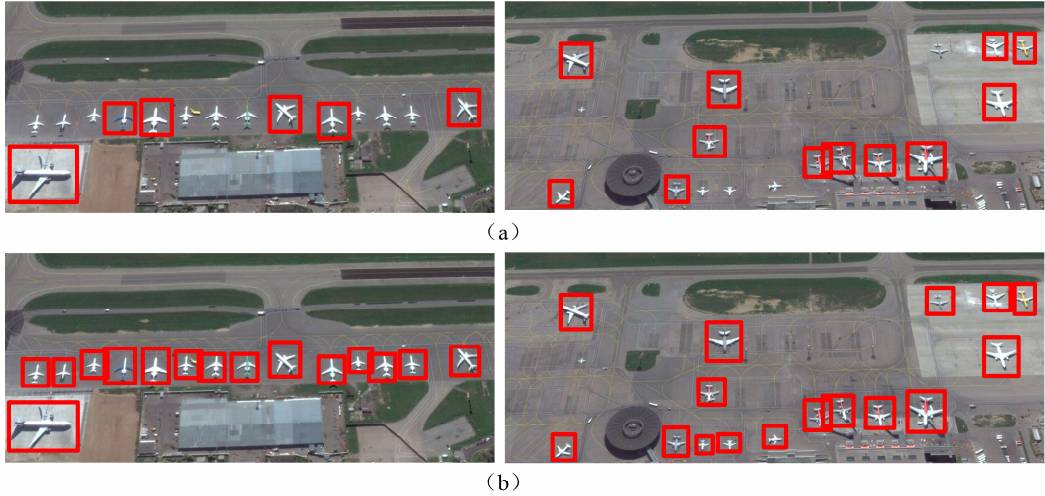
Figure 13. Results of different methods. ( a ): results with layer 5; ( b ): results with layers 3, 4, and 5.